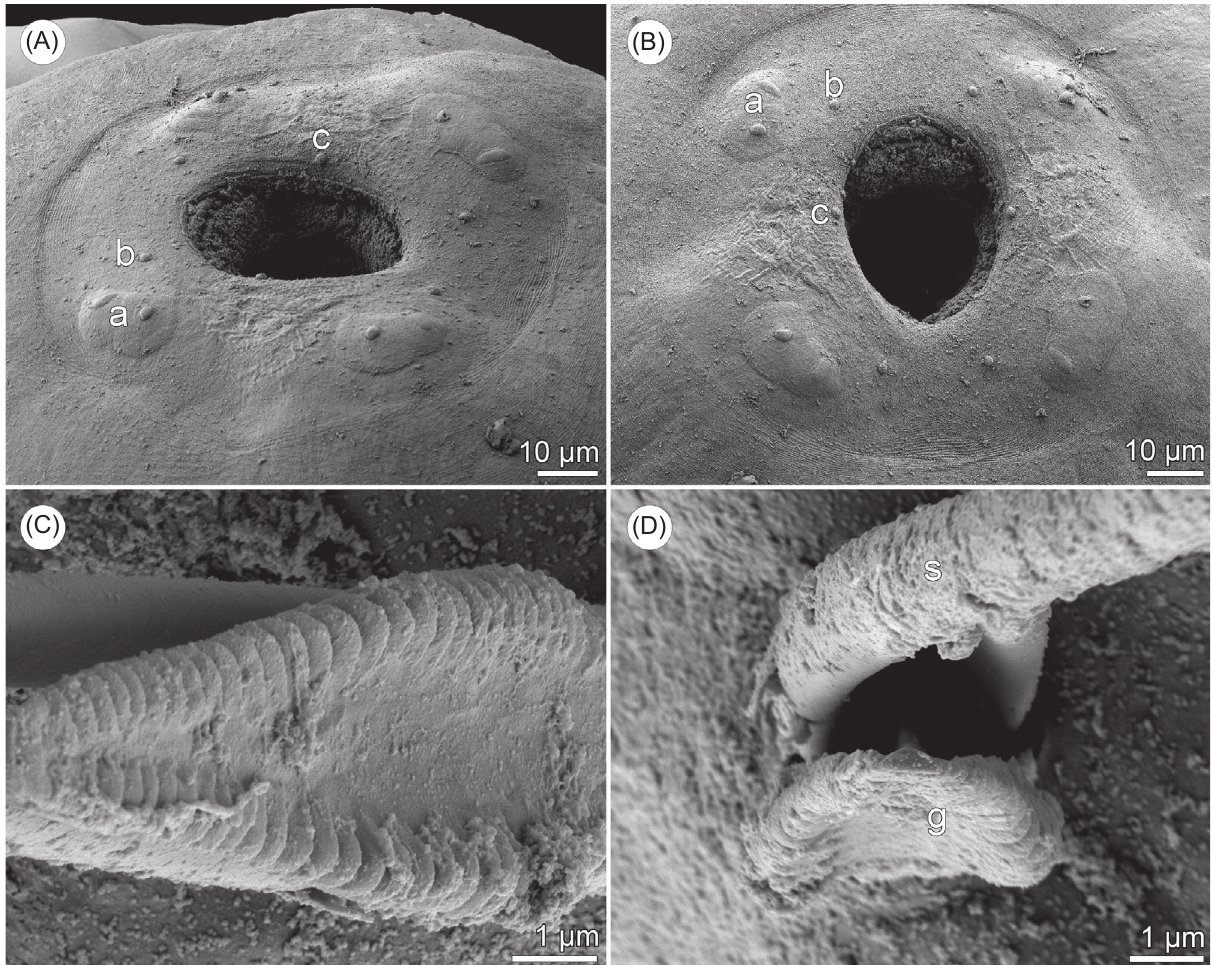
Figure 4. Philometra rara n. sp., scanning electron micrographs. (A, B) Cephalic end of subgravid female, dorsoventral and apical views, respectively; (C) posterior end of gubernaculum, dorsal view; (D) apical view of posterior end of gubernaculum with two distinct ventral longitudinal